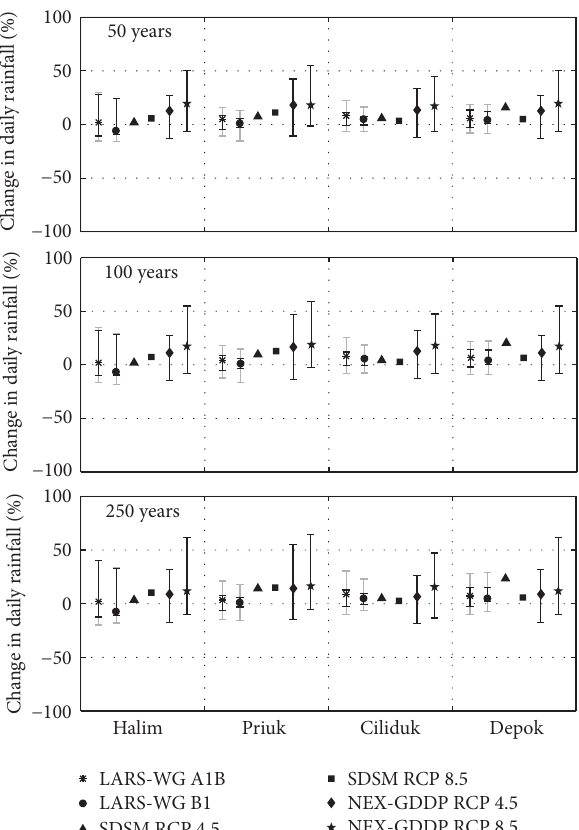
Figure 12: Same as Figure 11 but for wet season (December to